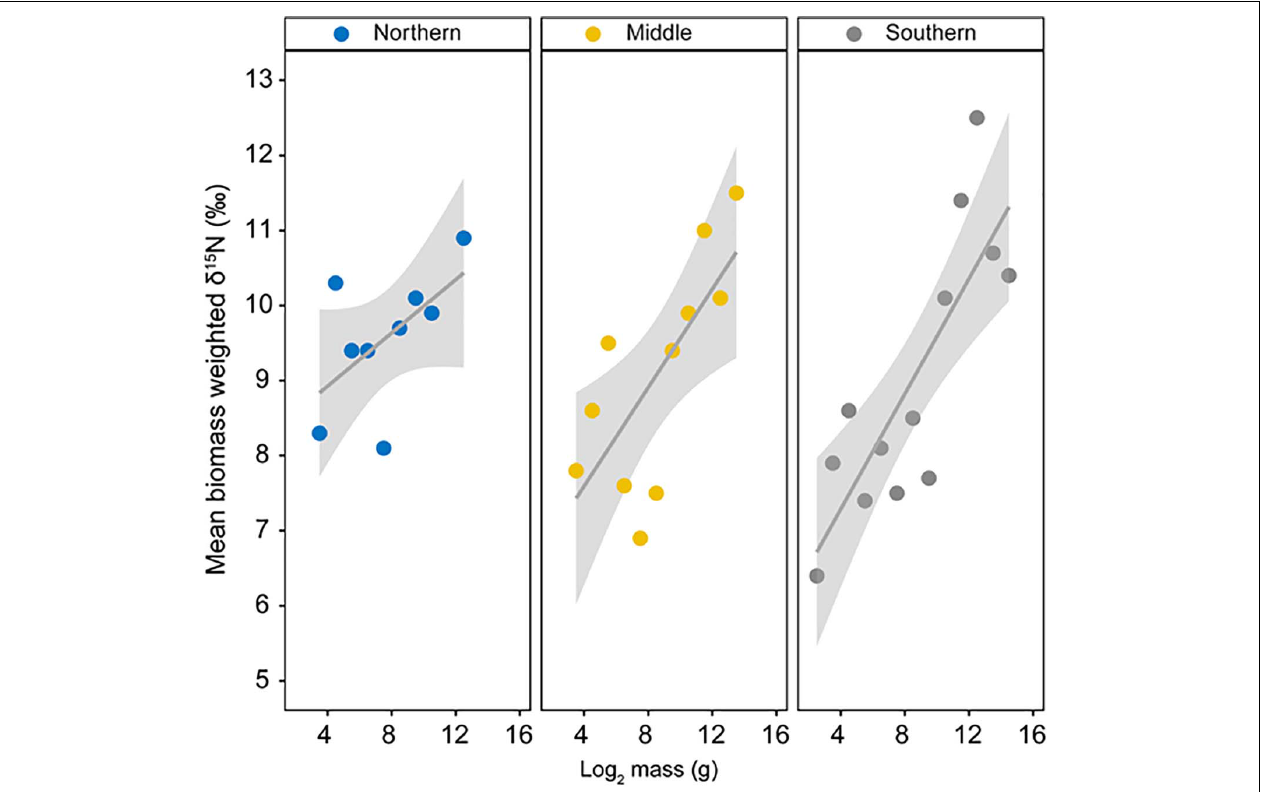
FIGURE 6 | Variation in community isotopic size spectra (relationship between δ 15 N and log 2 W (W- body mass in g) for fishes from the Northern, Middle and Southern areas of the Croatian part of the Adriatic